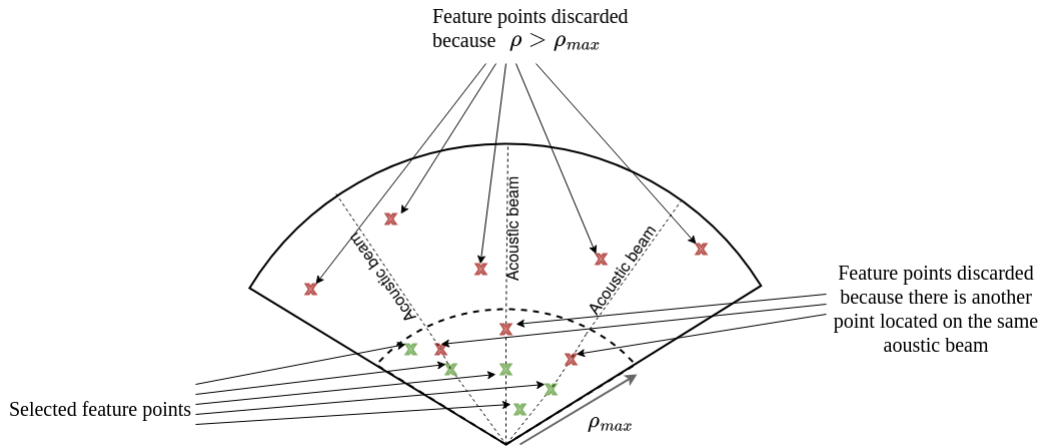
Figure 7. Illustration of the points’ selection process in the sonar image.